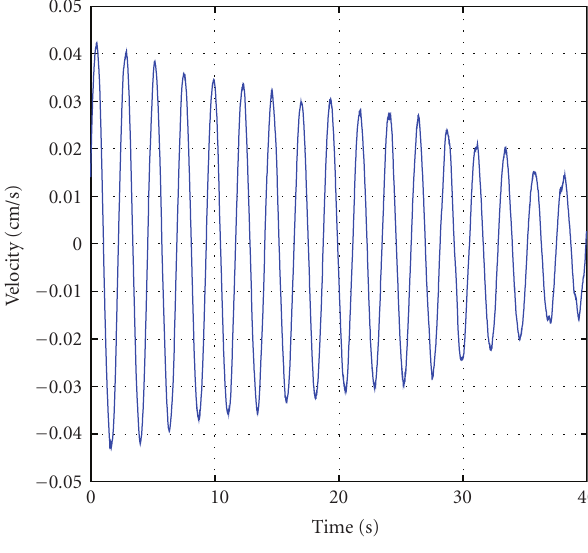
Figure 14: Measurement result by the developed wireless system. Figure 15: Measurement result by the conventional wired data